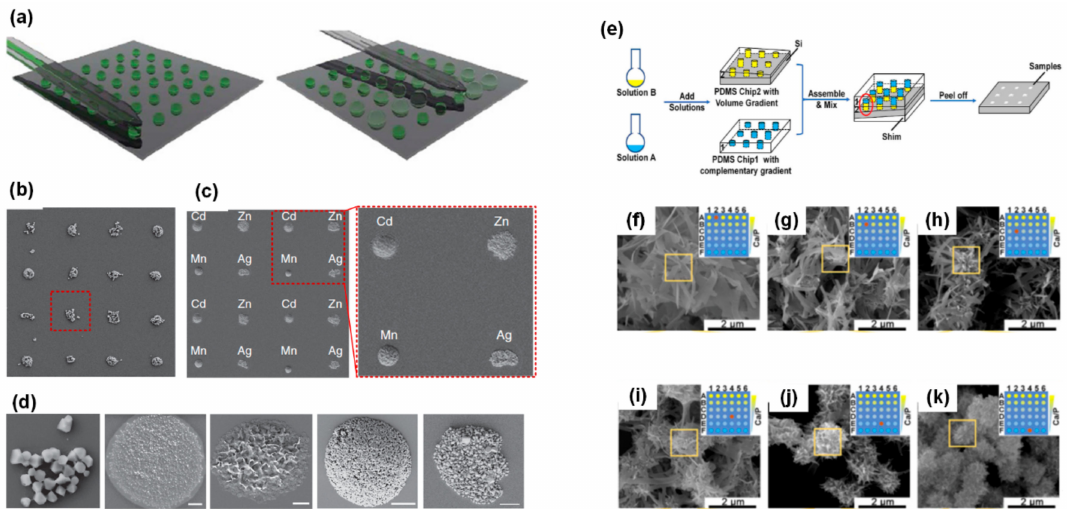
Figure 3. ( a ) Schematic illustration of two-step microfluidic pen lithography method, showing an array with precise delivery of di ff erent volume of a solution. ( b ) The synthesized HKUST-1 array. ( c ) The 4 × 4 array of the M-Prussian blue analogues, where M is Cd(II), Zn(II), Mn(II) and Ag(I). ( d ) The SEM images of HKUST-1, Cd-PBA, Zn-PBA, Mn-PBA and Ag-PBA nanocrystals (from the left images to the right, and scale bars are 2 µ m). Reproduced with permission from [107]. Copyright Nature Communications, 2013. ( e ) Schematic illustration of fabricating reactors based on microarrays, showing an array with precise partially perforated holes used to deliver solutions. ( f – k ) SEM images of calcium phosphates structures for screening the experimental concentration ratio of Ca(NO 3 ) 2 and (NH 4 ) 2 HPO 4 (scale bars are 2 µ m), ( f ) C ca / C p = 2.5 / 0.5; ( g ) C ca / C p = 2.1 / 0.9; ( h ) C ca / C p = 1.7 / 1.3; ( i ) C ca / C p = 1.3 /